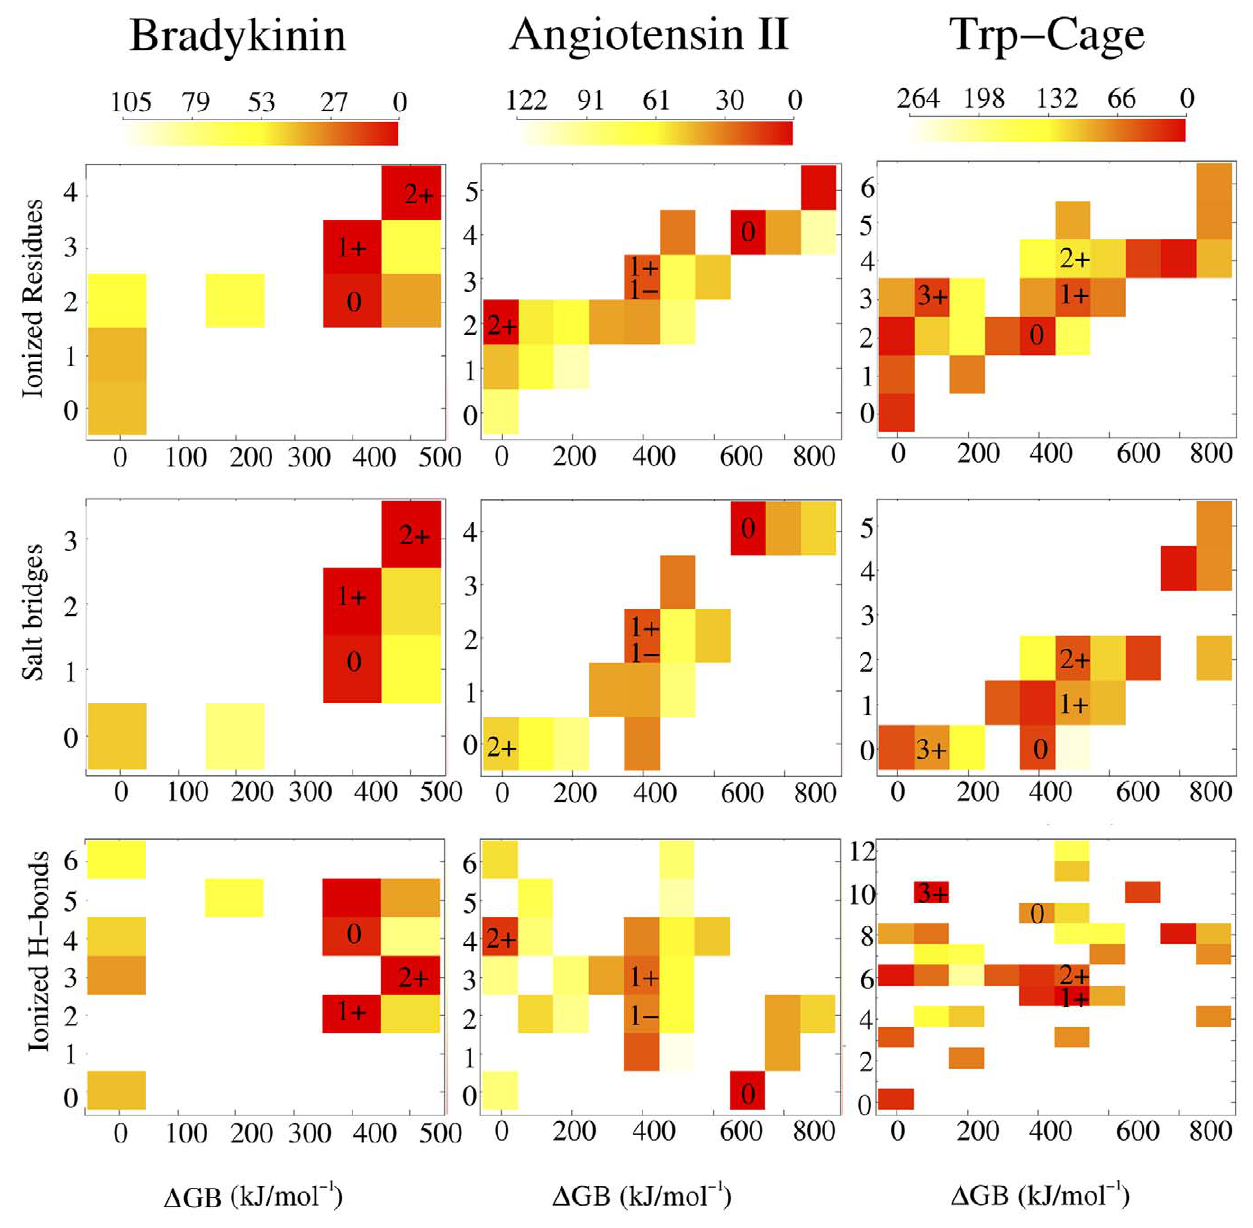
Figure 2. Energy/structure relationship for angiotensin II, bradykinin, and Trp-cage. The color scale refers to the average energy (kJ/mol) of polypeptides with the given pair of parameters. D GPB stands for thermodynamic penalty to create a zwitterionic state expressed in terms of residues intrinsic gas-phase basicities (see text for the definition). In each panel, numbers indicate the location of lowest-energy protomers.